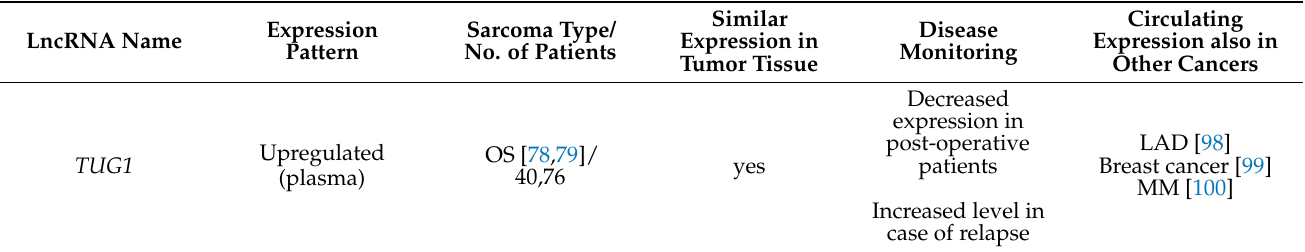
Table 2. List of lncRNAs identified in